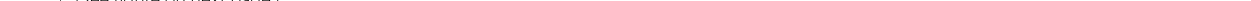
figure on next Fig. 1 T-statistical map of significant clusters in the voxel-based two sample t tests of 18 F-FDG PET of visual snow syndrome patients (VSS) versus healthy controls (CON). A Red–yellow scale shows increased glucose metabolism in VSS compared to CON. The color bar represents t values for SPM group comparison at p FWE < 0.05 corrected for multiple comparisons on voxel level ( k ext (VSS > CON; purple: p FWE < 0.05; red: p height,uncorrected < 0.001) and hypometabolic (VSS < CON; blue: p height,uncorrected < 0.001) regions in VSS compared to CON. L left, R right. C Plot of the effect in the visual cortex (left; peak voxel Talairach coordinate [ = = medial temporal cortex (right; peak voxel Talairach coordinate [ 1–15 and VSS